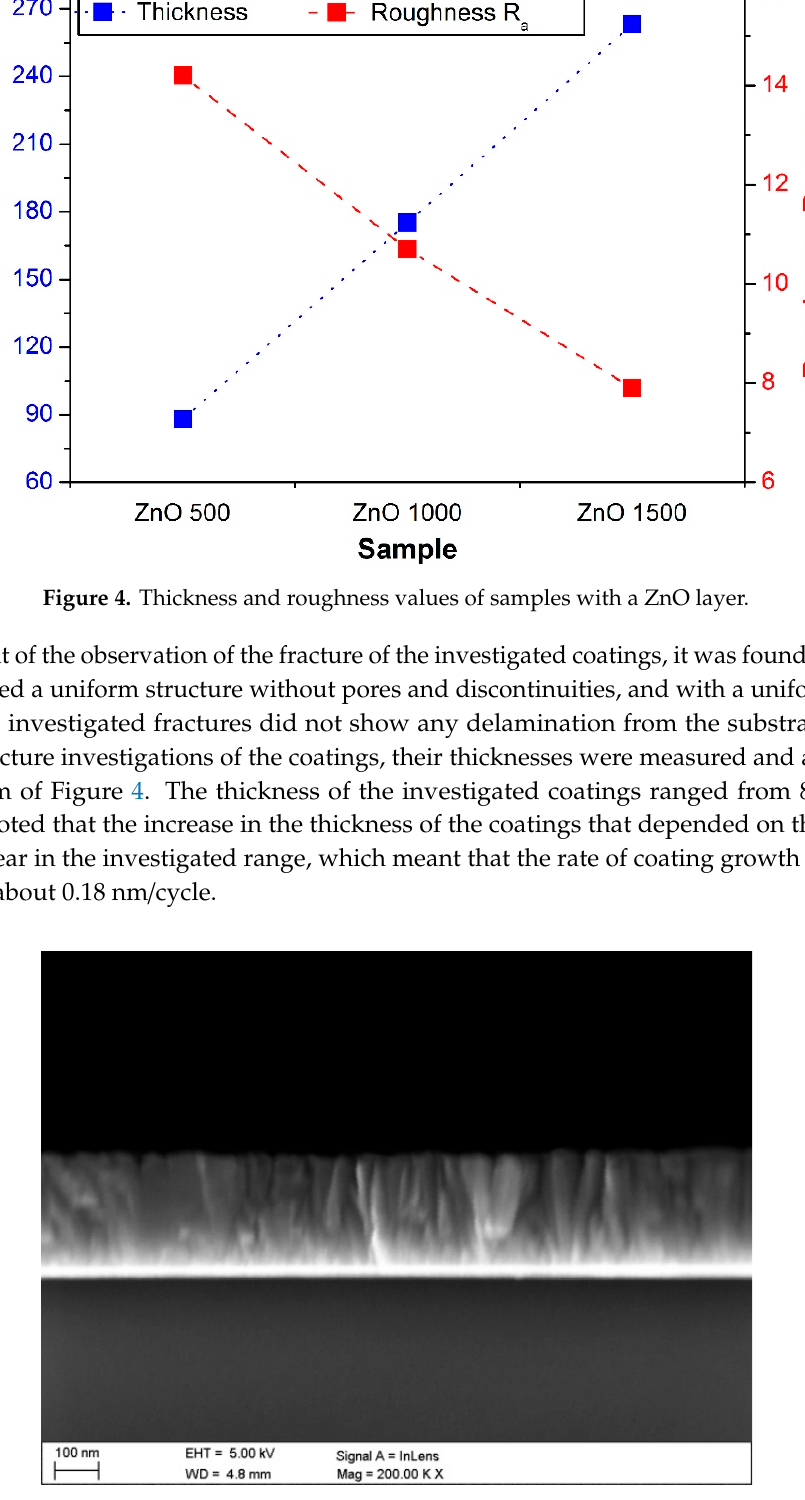
Figure 5. Fracture of the ZnO coating deposited in 1500 ALD cycles .